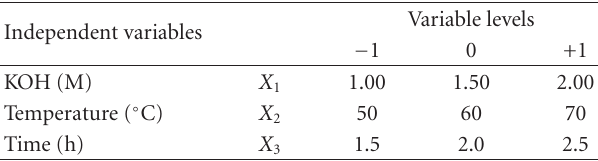
Table 1: Independent variables and their levels for D-optimal design of the saponification